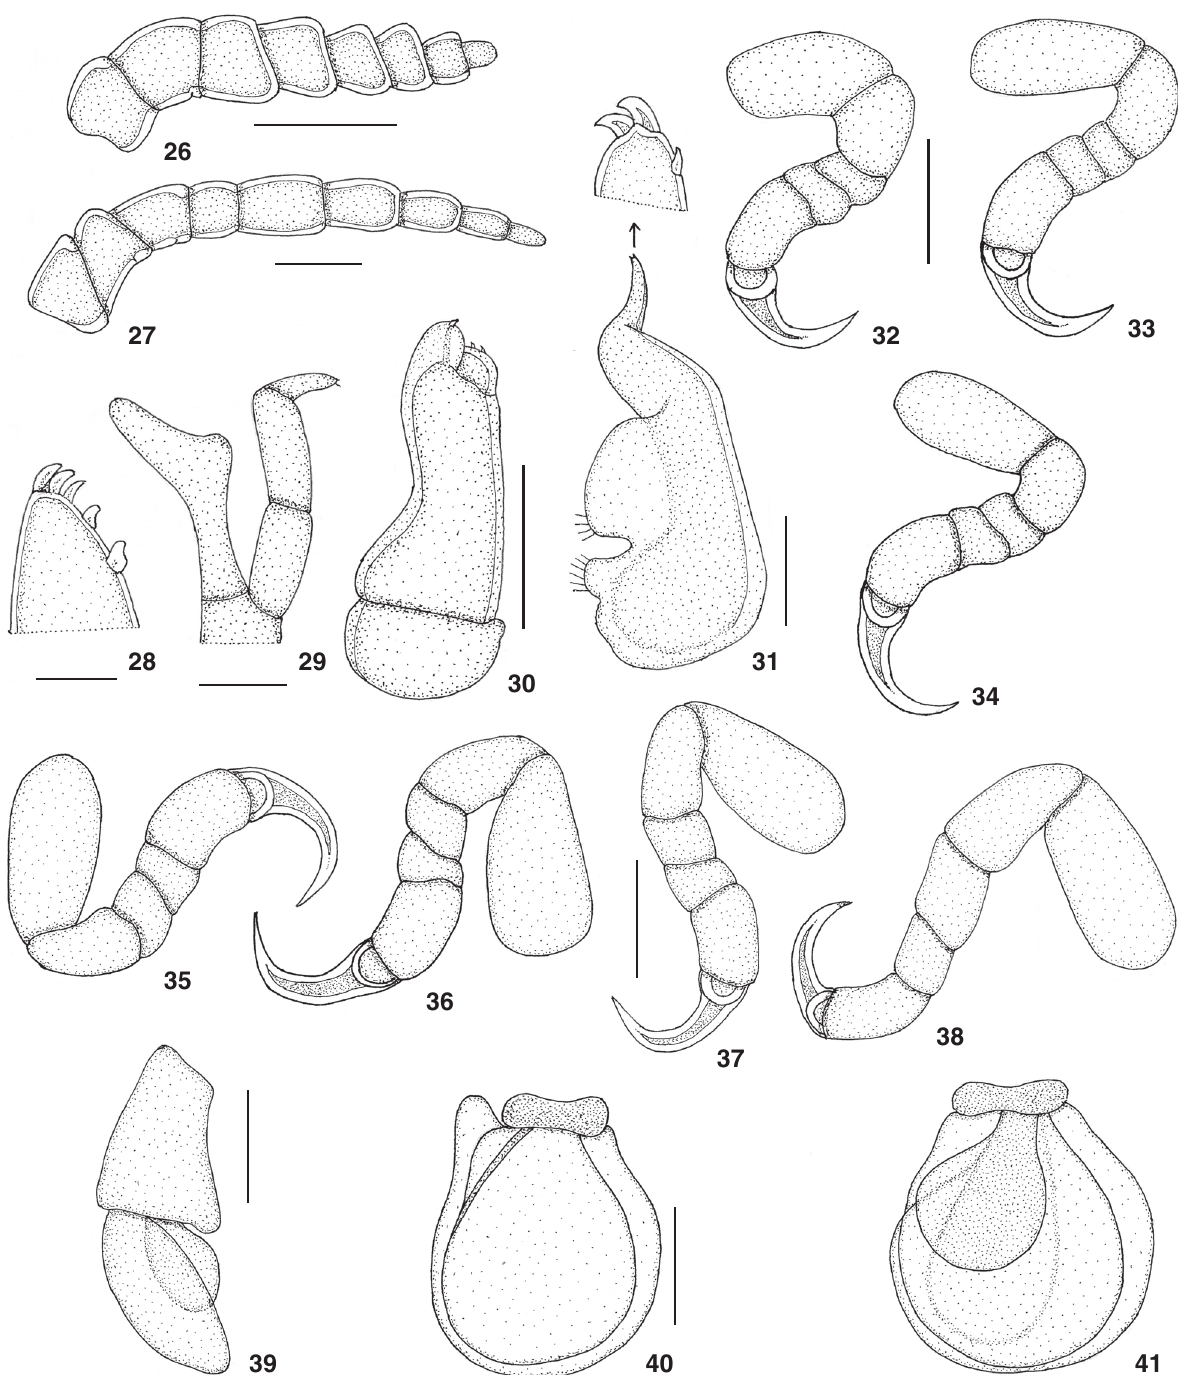
Figures 26-34. Braga cigarra comb. nov. , male: (26) antennule; (27) antenna; (28) tip of maxillule; (29) mandible and palp; (30) maxilla; (31) maxilliped; (32) pereopod 1; (33) pereopod 2; (34) pereopod 3; (35) pereopod 4; (36) pereopod 5; (37) pereopod 6; (38) pereopod 7; (39) uropod; (40) pleopod 1; (41) pleopod 2. Scales: 26, 27, 30-31, 39 = 1 mm; 28 = 100 µm; 29 = 50 µm; 32-38 = 2 mm, 40-41 = 3 ZOOLOGIA 26 (1): 155–160, March, 2009